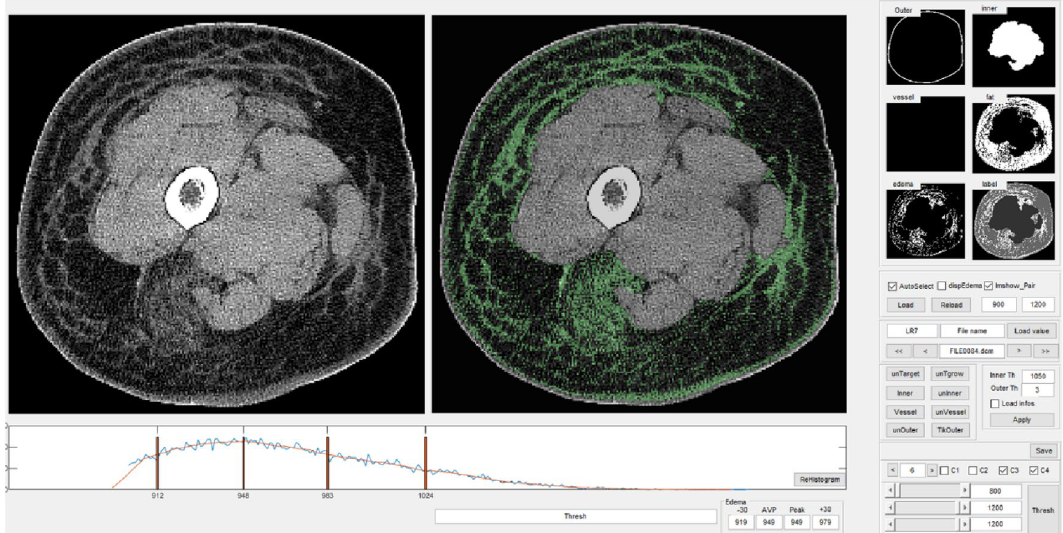
Figure 4. Developed GUI used to categorize every pixel into one of five classes (air, skin, muscle/water, fat, and fibrosis). The pixels classified as fibrosis are marked in